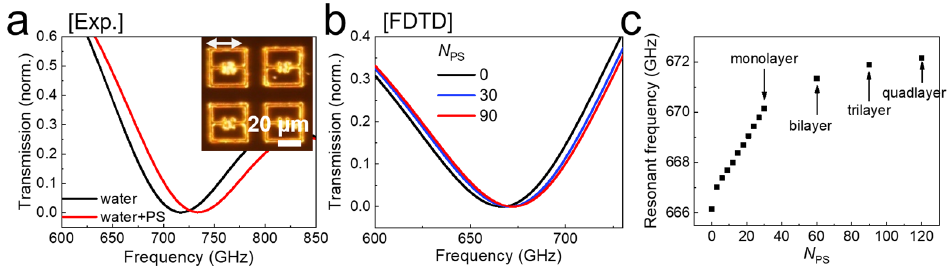
Figure 2. ( a ) Experimentally obtained THz transmission amplitude (normalized) of the surface- functionalized fluidic metamaterials after circulation of the specimen with (red solid line) and without (black solid line) the PS in the water. (inset) Dark-field microscope image of metamaterials with PS captured in the gap area. ( b ) Simulated THz transmission amplitude of the metamaterials with a 20 µ m thick water layer for N PS = 0, 30, 90. ( c ) The resonant frequency of the metamaterials as a function of N PS